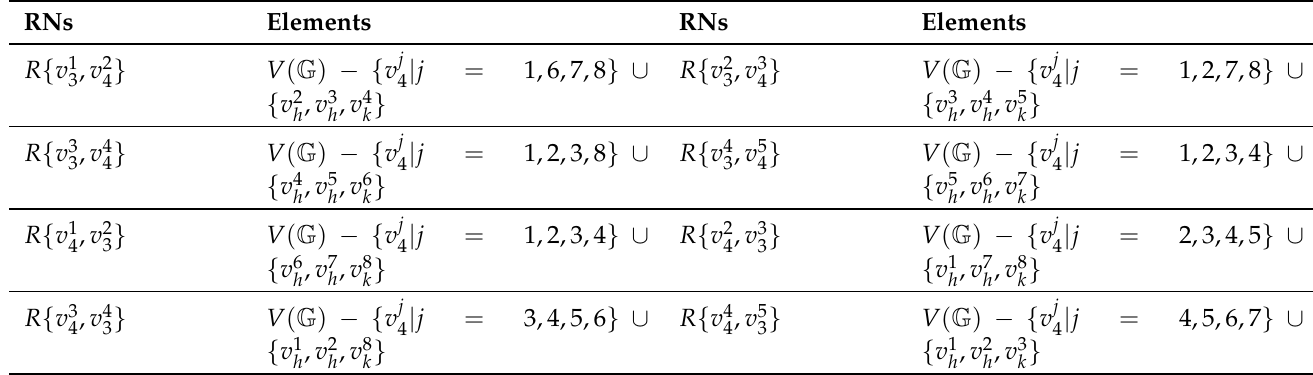
Table 20. RNs ´ R u for 98 ≤ u ≤ 105 1 ≤ h ≤ 3 and 2 ≤ k ≤ 3. RNs Elements RNs